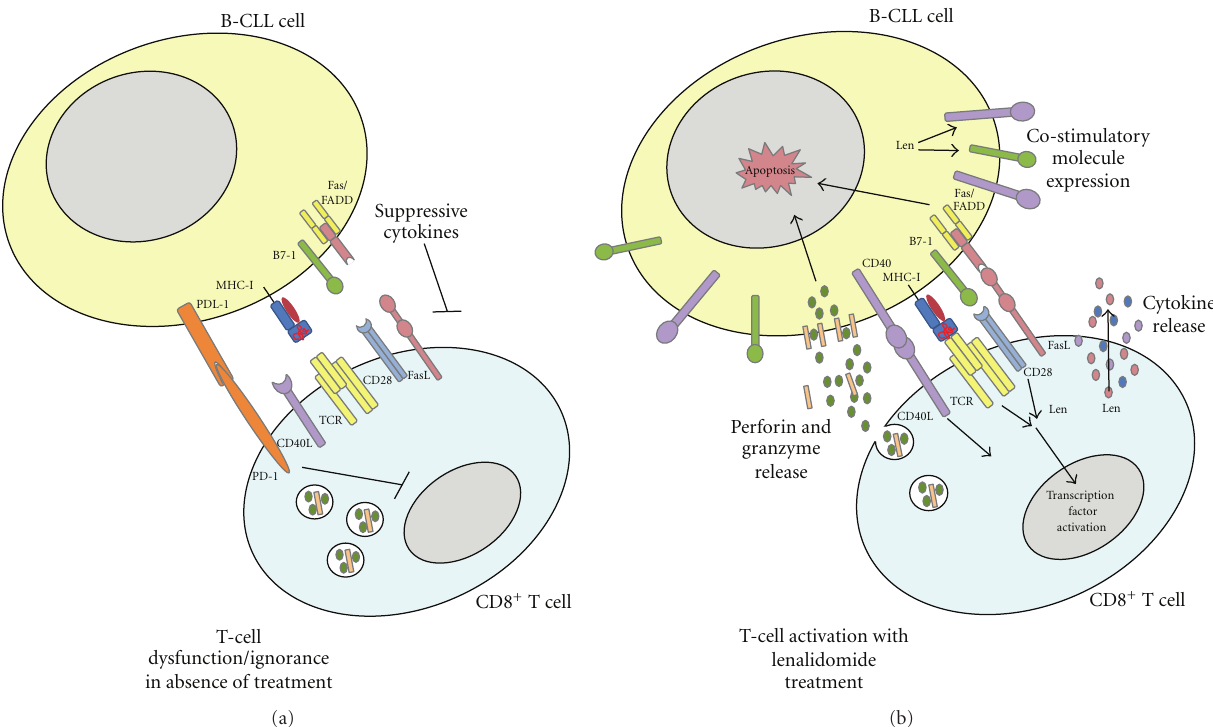
Figure 2: Lenalidomide augments direct CD8+ T-cell killing of B-CLL cells. B-CLL cells are able to evade immune detection through high levels of PDL-1, low levels of costimulatory molecules like B7-1, and a variety of immune-suppressive cytokines in the microenvironment. Lenalidomide treatment (Len) is able to overcome the immune suppression through upregulation of costimulatory molecules like CD40 and B7-1 (CD80/86) on the CLL cells, upregulation of Fas expression, as well as decreasing PDL-1. Through the alteration of surface molecule expression, as well as the increase in T-cell signaling as shown previously, lenalidomide induces better immune synapse formation allowing for increased killing by the CD8+ T